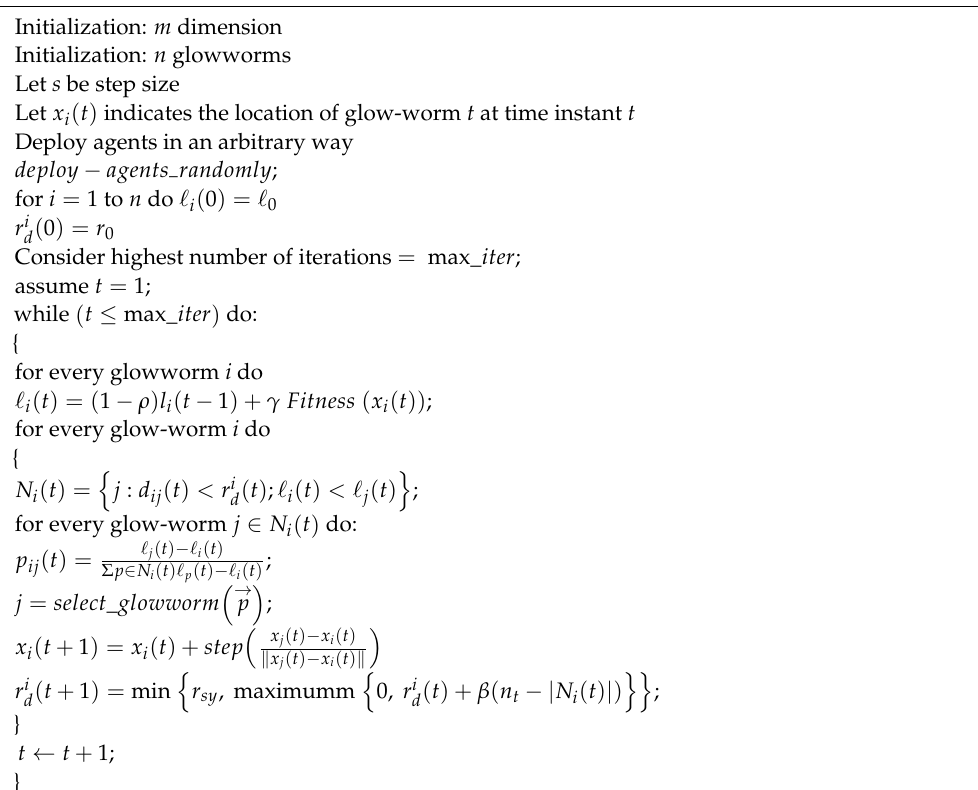
Algorithm 1: Pseudocode of GSO